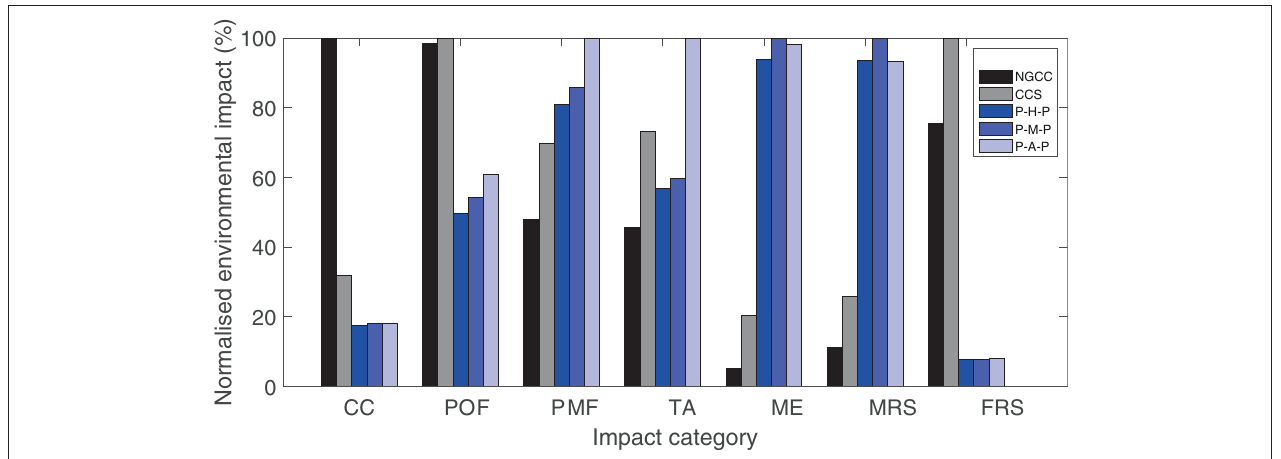
FIGURE 8 | Comparison of cradle-to-factory gate environmental impact of 1 kWh dispatchable electricity for the studied cases on seven selected impact categories. Results normalized to the system with the highest impact (set to be 100%). CC, Climate Change; POF, Photochemical Ozone Formation; PMF, Particulate Matter Formation; TA, Terrestrial Acidification; ME, Marine Eutrophication; MRS, Mineral Resource Scarcity; FRS, Fossil Resource